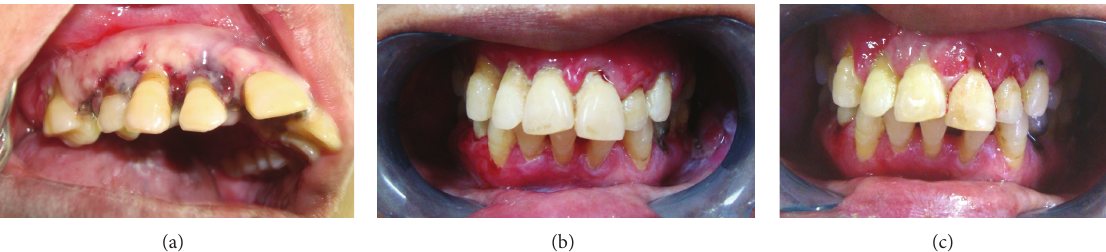
Figure 4: (a) shows follow-up after 1 week with initial healing. (b) shows healing after one month. (c) shows gingival status on 8-month